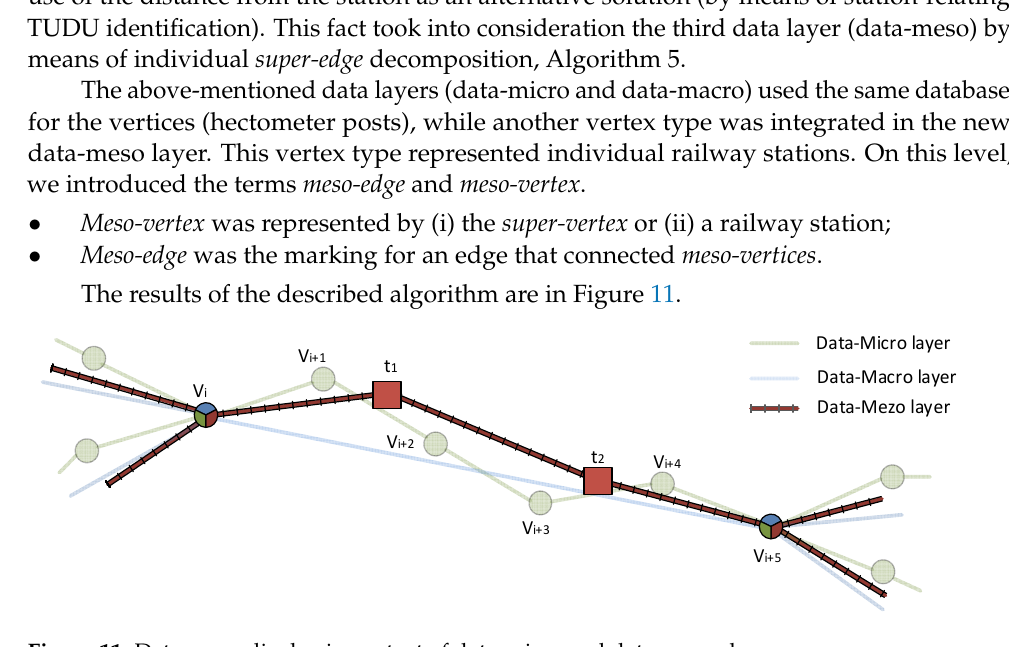
Figure 11. Data-meso display in context of data-micro and data-macro